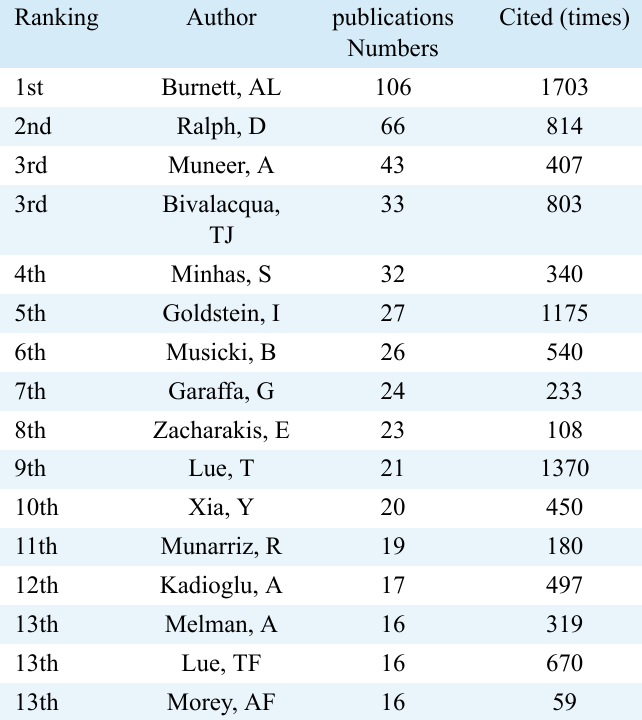
TABLE 4. The most productive authors on the research of priapism (Top